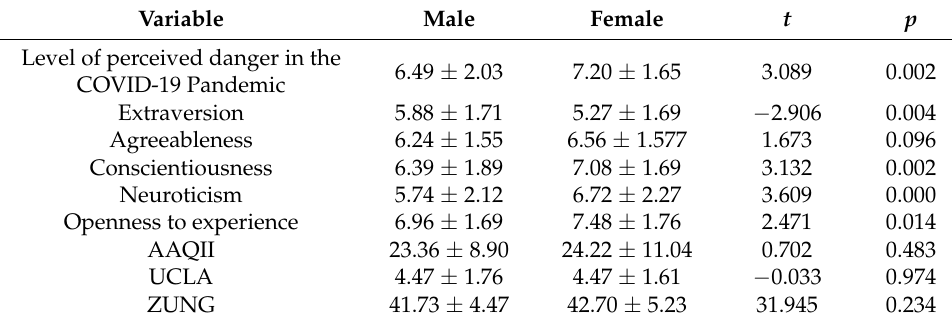
Table 3. Gender differences in psychological